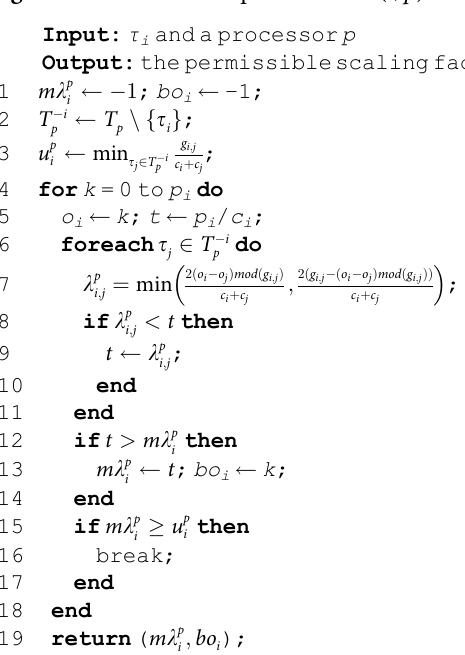
Algorithm 1: Best center procedure BC ( i , p